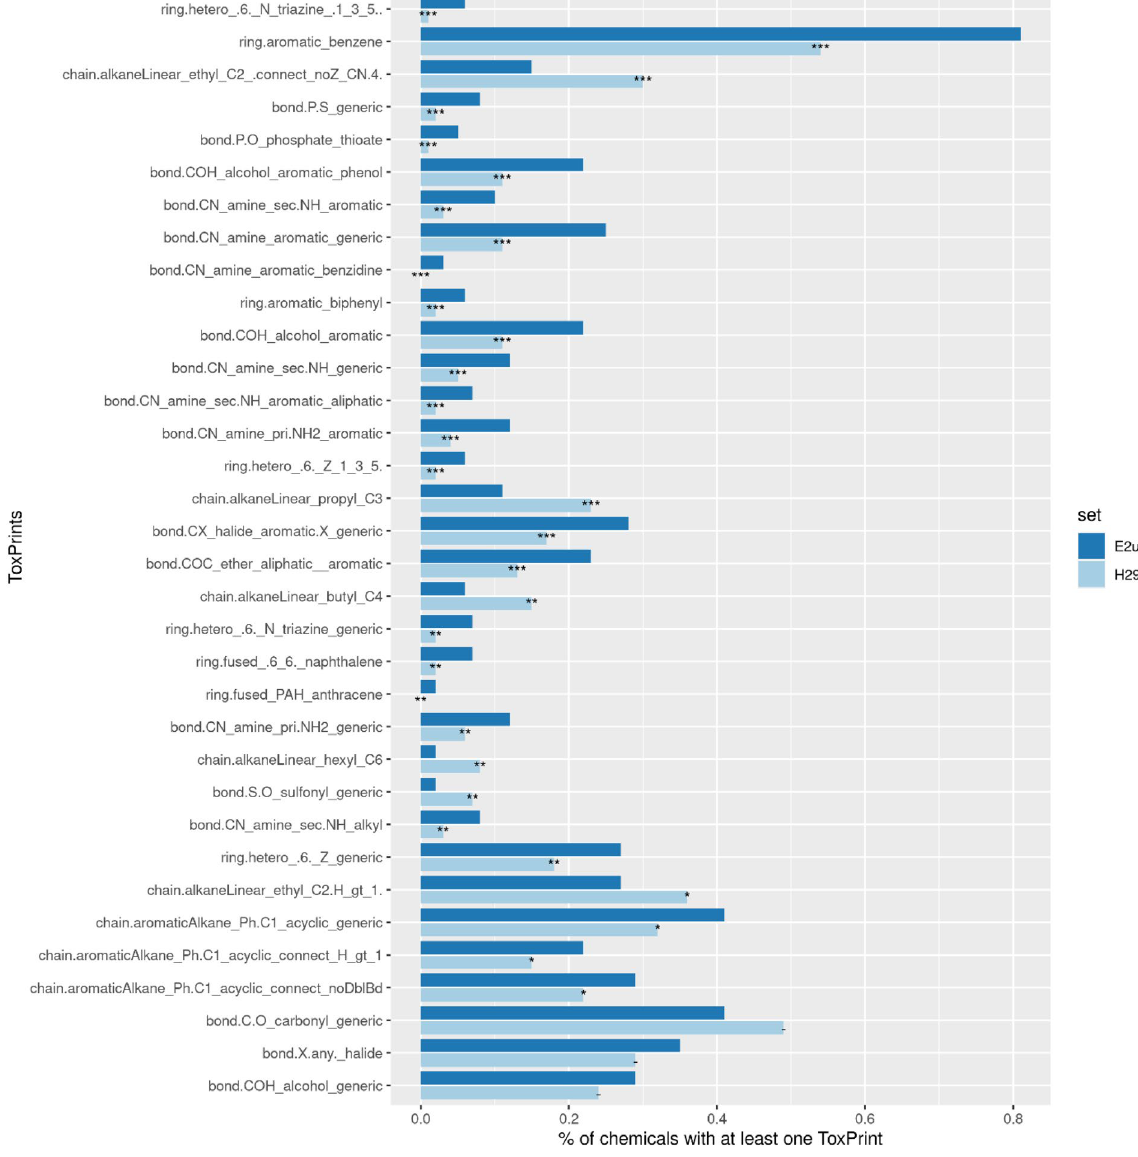
Figure 6. Distribution of ToxPrints that are significantly more common and the most represented (present in > 20% E2up chemicals) among the 729 ToxPrints identified in E2up chemicals. Statistical significance was computed using a Pearson’s chi-squared test and significant p-values are reported as: p-value < 0.001 (***), p-value < 0.01 (**), p-value < 0.05 (*) and p-value ≥ 0.05 (−). ToxPrints are ordered by p-values, from the most significant to the